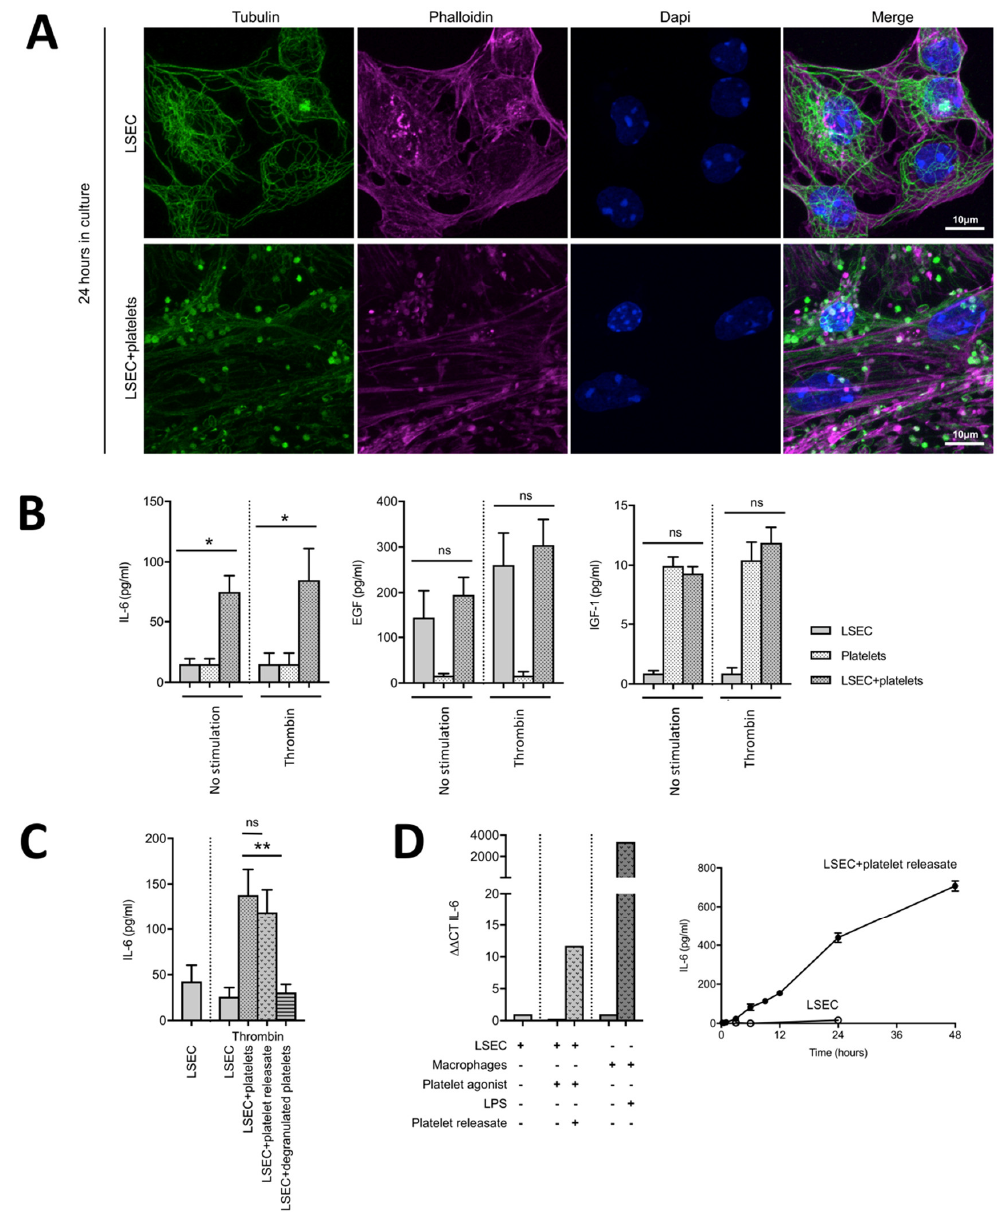
Figure 3. The releasate of activated platelets is necessary to e ffi ciently induce IL-6 release from LSECs. ( A ) LSECs alone and LSECs co-cultured with platelets for 24 h were stained with antibodies against tubulin (green) and phalloidin (magenta, to stain the actin cytoskeleton). Nuclei are stained with dapi (blue). Scale bars, 10 µ m. ( B ) Concentrations of IL-6, EGF and IGF-1 at 24 h in the culture medium of LSECs with 16 million platelets without stimulation or with pre-activation using thrombin. N = 4, * p < 0.05. ( C ) Secretion of IL-6 at 24 h of culture of LSECs in the presence of either 16 million activated platelets (platelets), their soluble fraction (platelet releasates) or their membrane fraction (degranulated platelets). Platelets and their fractions were obtained after activation by thrombin. N = 8, ** p < 0.001. ( D ) Left panel: IL-6 mRNA expression in LSECs cultured for 24 h in the presence or not of activated platelet releasate, platelet agonist, macrophages, and / or LPS. N = 2. Right panel: Kinetics of IL-6 secretion from LSECs alone or LSECs with activated platelet releasate. N = 2.